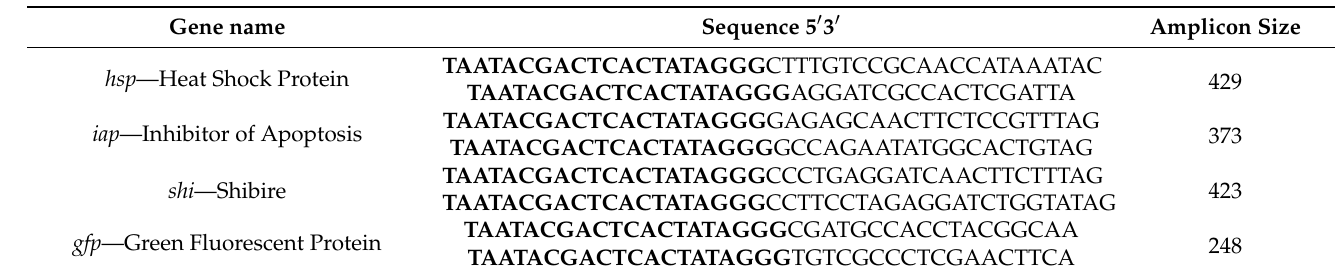
Table 2. Target gene dsRNA amplicon size and primer sequences, including the T7 promoter sequence